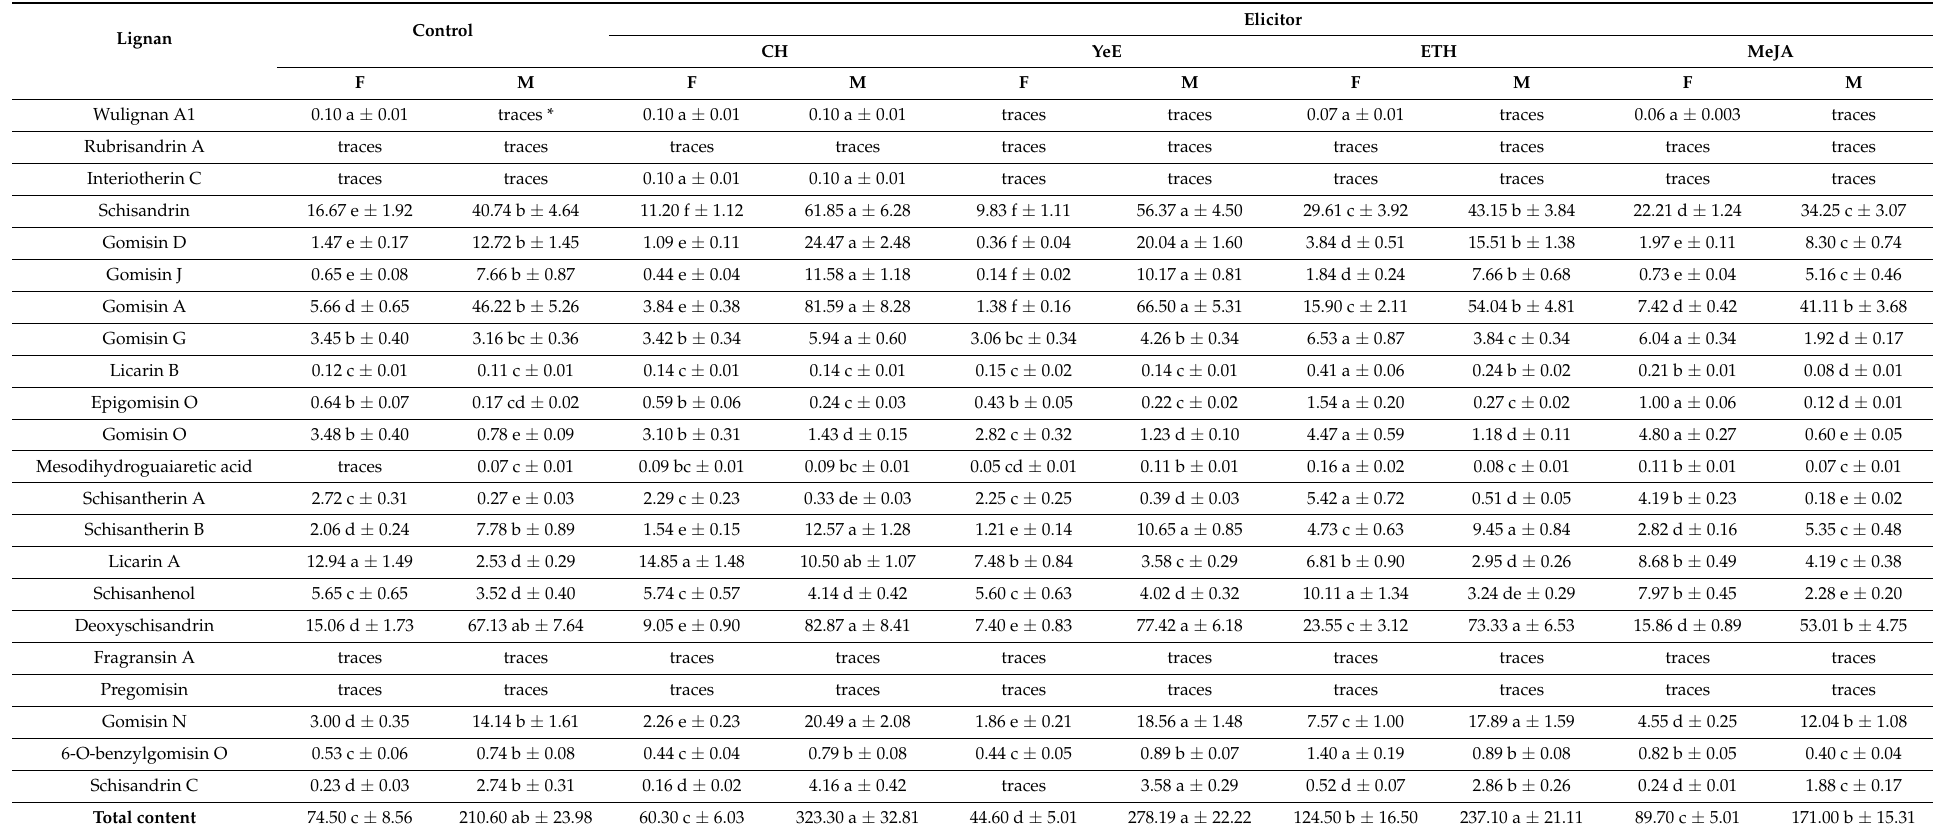
Table 3. Accumulation of lignans (mg/100 g DW) in agitated cultures of S. rubriflora lines F and M 48 h after addition of elicitor. Data expressed as the